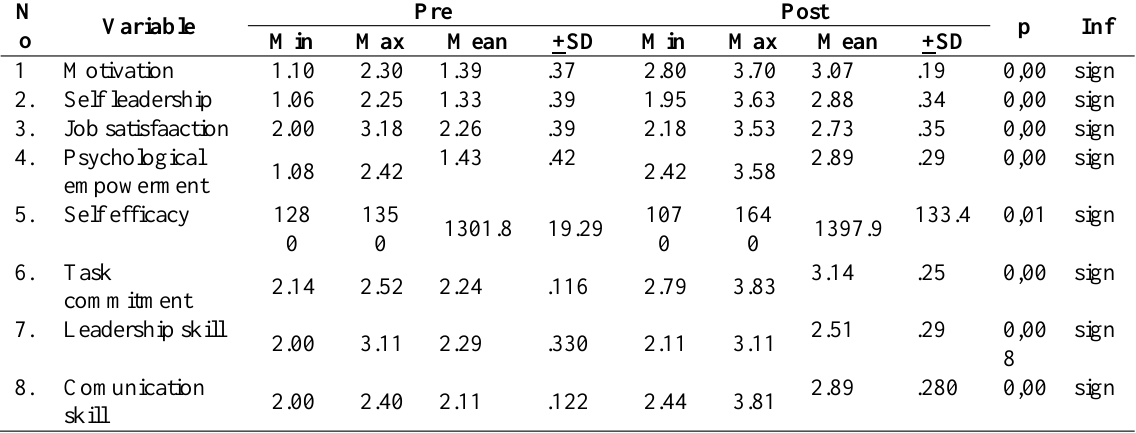
Table 3. Results of the Pre- and Post-Data Analysis Training of Self Leadership Capability Development In Students of Midwifery in Sutomo